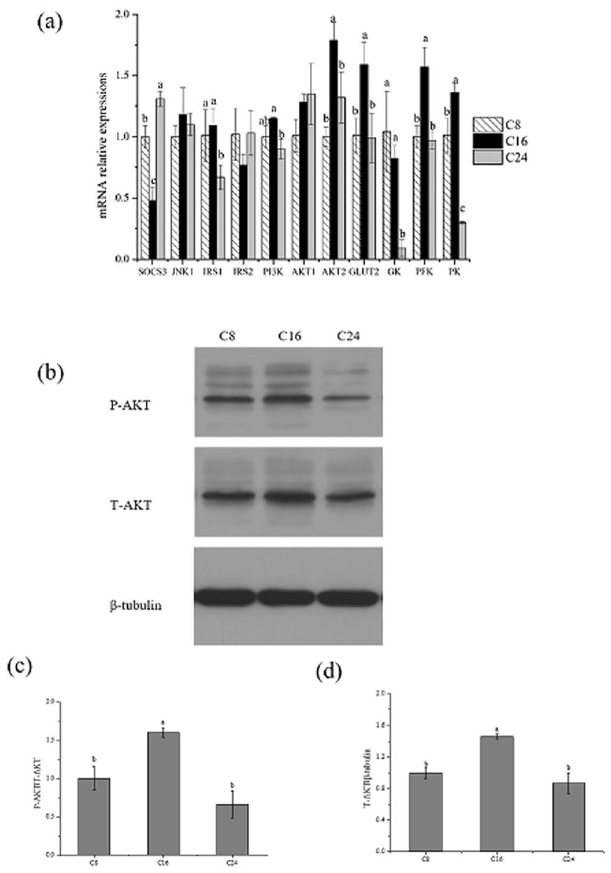
Figure 4. Gene and protein levels in liver of Japanese flounder after the 10-week feeding trial. ( a ) Expressions levels of glucose metabolism related genes were normalized to β -actin levels and expressed as relative expression values to those in C8 group. (b) The relative protein abundances of T-AKT and P-AKT in livers were expressed as relative expression values to those in C8 group. (c,d) The bars represent the mean ± S.D., n = 3 (8 fish/ replicate). Values with different letters mean significantly different ( P < 0.05). Unprocessed original scans of blots are shown in Supplementary Fig.